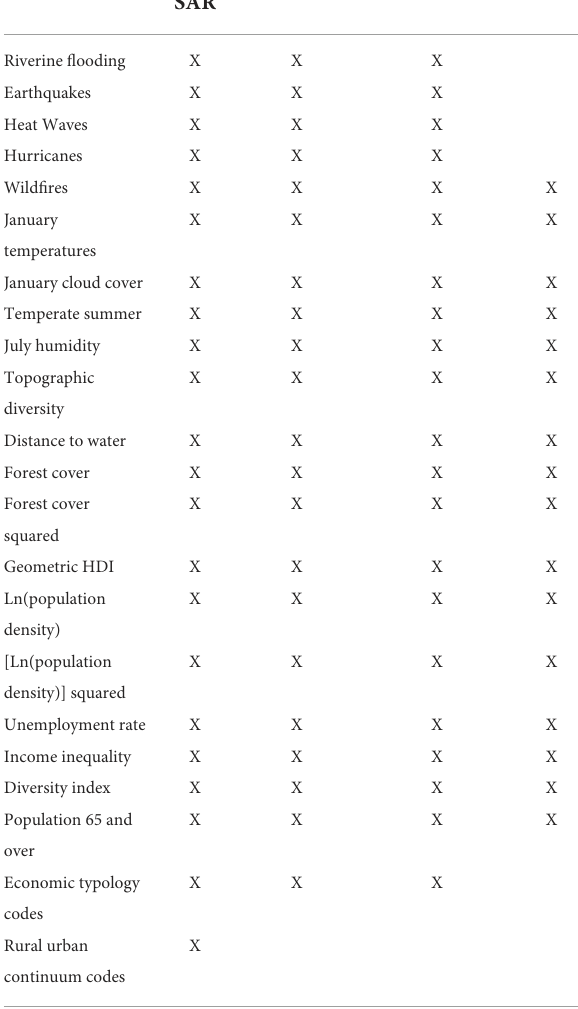
TABLE 3 Summary of variables used in each model.